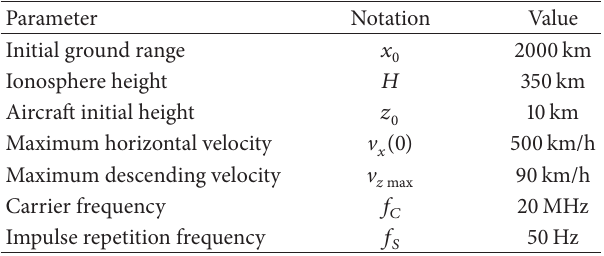
Table 1: The parameters of the motion